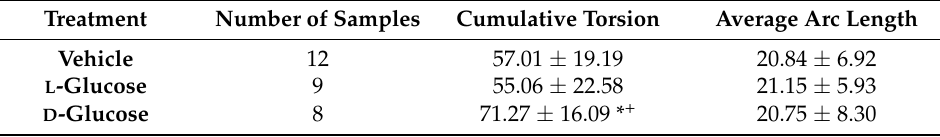
Table 2. Cumulative Torsion Statistical Analysis.